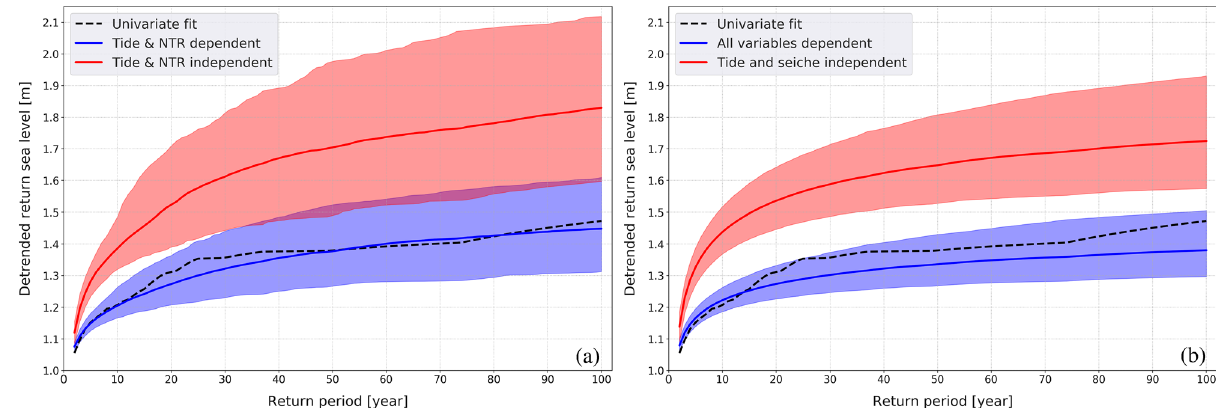
Figure 5. Return sea levels and periods obtained from the univariate fit of ESLs and as modelled considering the combination of two (panel a ) and five (panel b ) variables. Model’s median (solid line) and 95% confidence interval (band) are